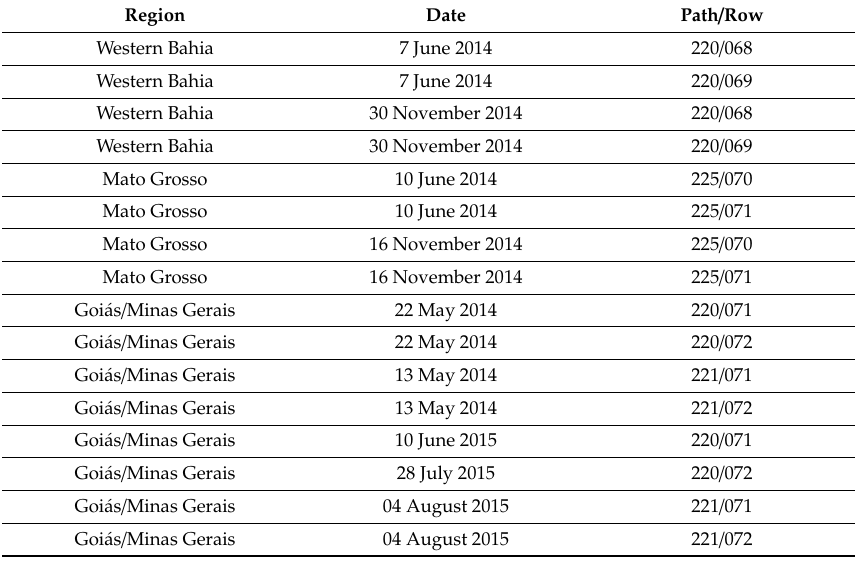
Table 1. Landsat-8 Operational Terra Imager (OLI) images used in the training and validation stages. Region Date Path /